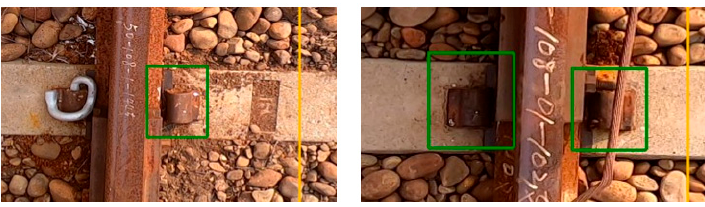
Figure 5. Three samples of severely defective (XX) track components where the fasteners are miss ‐ ing. Table 3. Top ‐ view dataset.